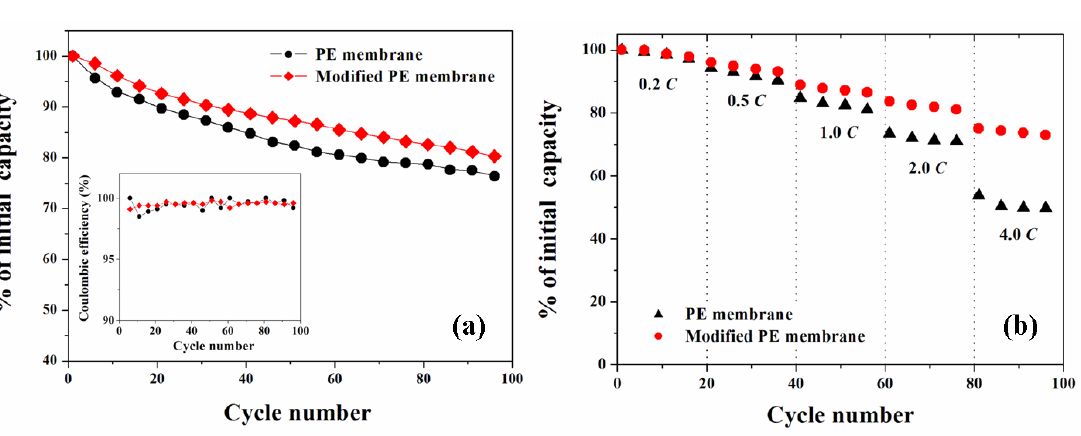
Figure 8. (a) Discharge capacity of the LIPB cells fabricated with PE or modified PE membranes as a function of cycle number. The inset shows the variations of the Coulombic efficiency of the corresponding LIPB cells with the cycle number. (b) Rate capability of the LIPB cells fabricated with PE or the modified PE membranes as a function of cycle